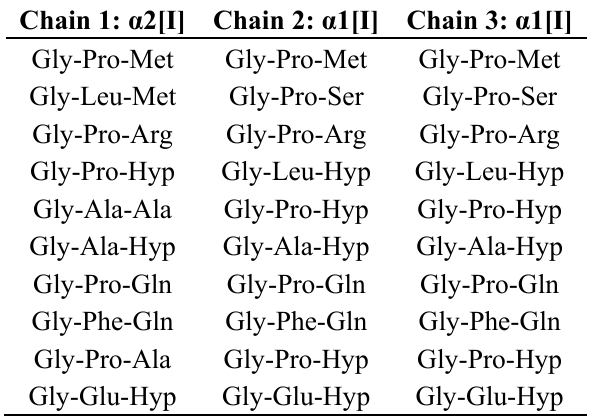
Table 1. List of amino acids in the 7-2 heterostructural